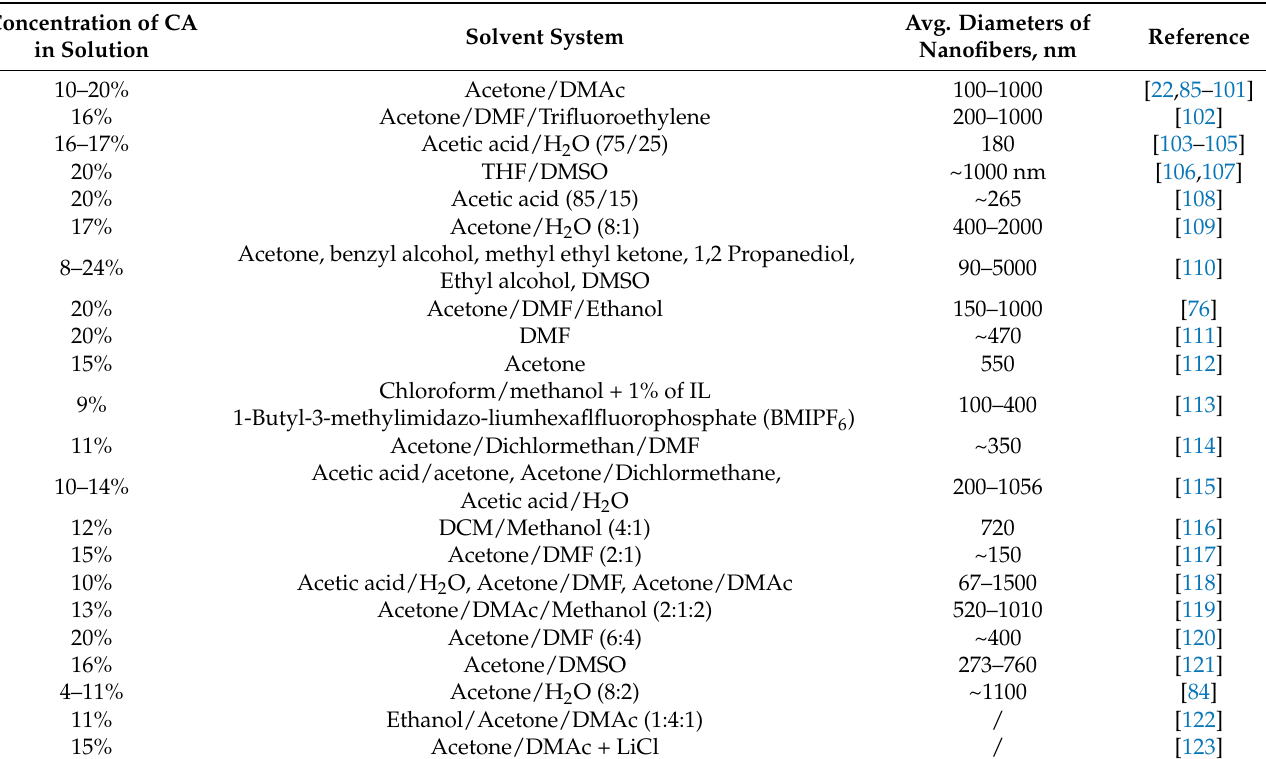
Table 4. Summary of various solvent systems and CA concentrations used for electrospinning of